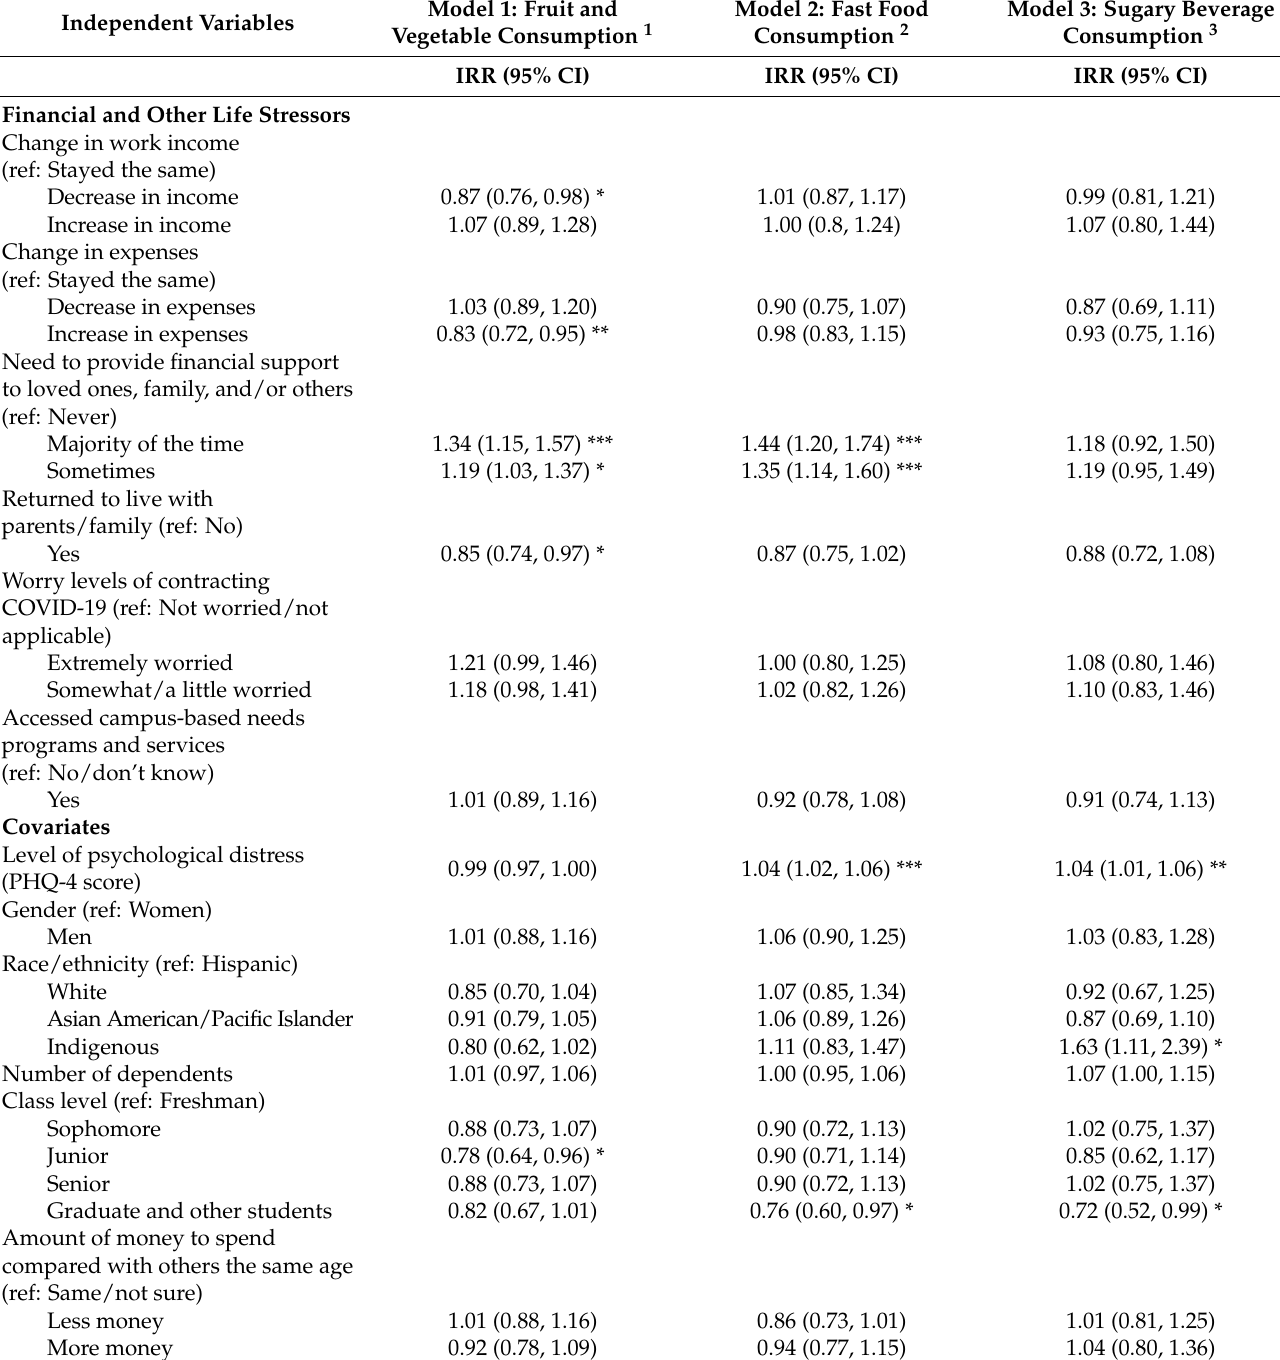
Table 3. The potential impact of financial and other life stressors and psychological distress on food and beverage consumption behaviors during the COVID-19 pandemic after controlling for sociodemographic characteristics: Results from the Health During the COVID-19 Pandemic Student Survey , California State University, Los Angeles,